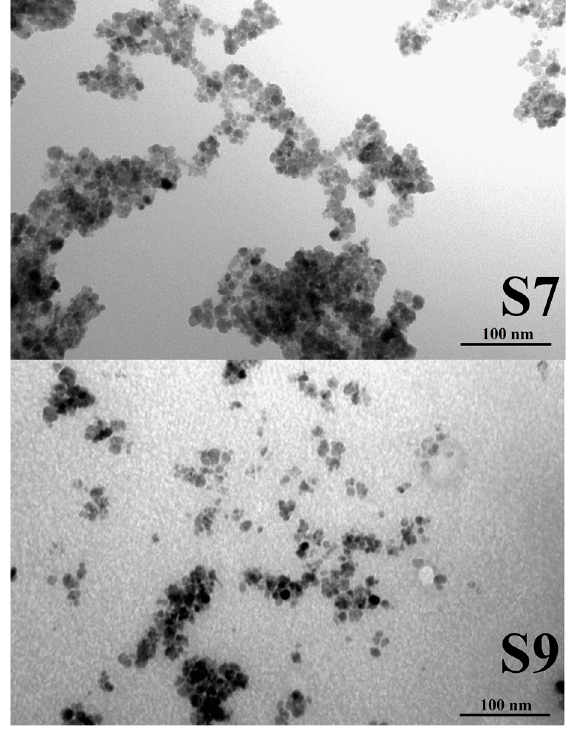
Figure 7. Micrographs of MIONs obtained using the TEM technique. Table 5. The particle size data extracted from the TEM images.